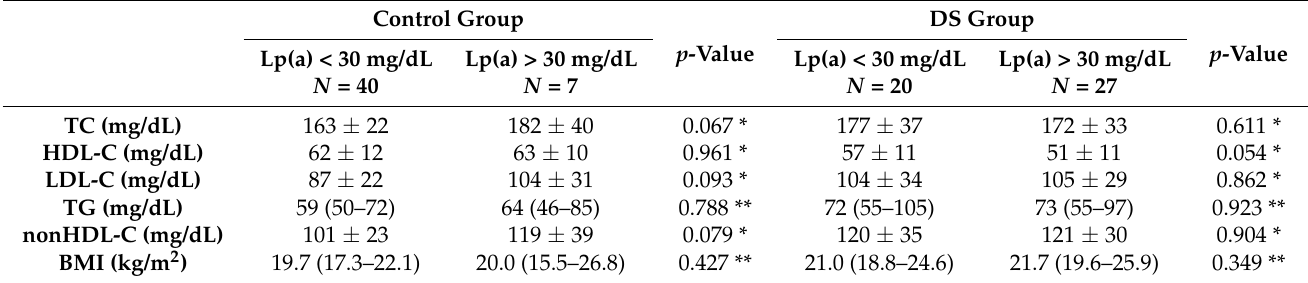
Table 3. Lipid profile parameters and BMI in the context of Lp(a) levels in study population. Control